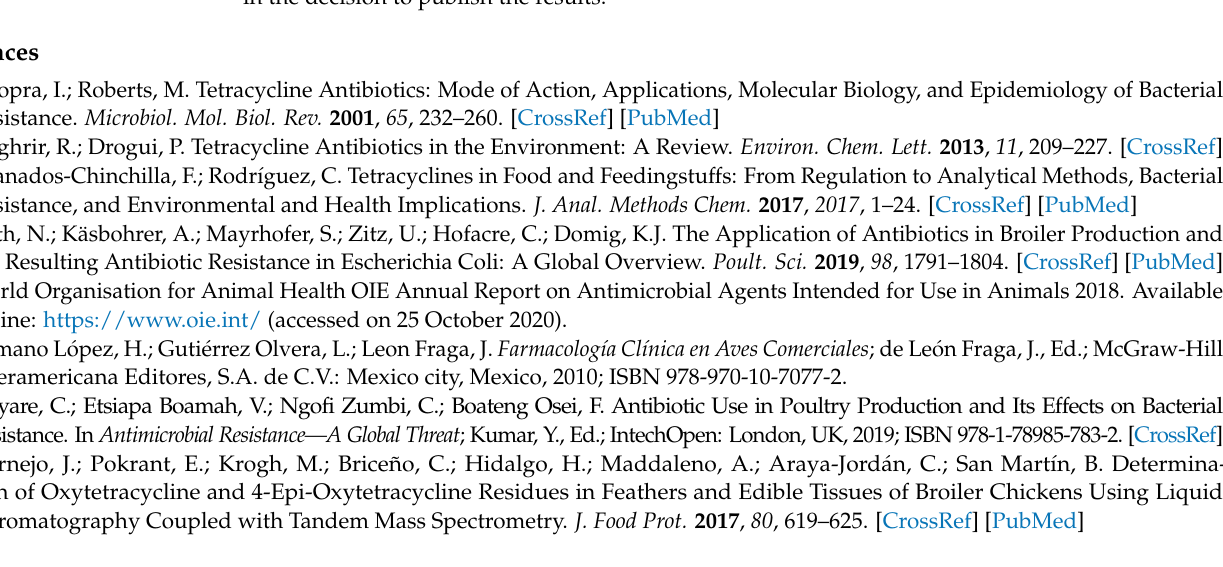
Table S3. Substance specific mass spectrometric conditions, Table S4. Validation parameters and acceptance criteria following guidelines 2002/657/EC and VICH GL49 for validation of analytical methodology, Table S5. Validation of analytical methodology: Precision and recovery for droppings and litter, Figure S1: Representative OTC chromatograms of the first sampling (1-day post the end